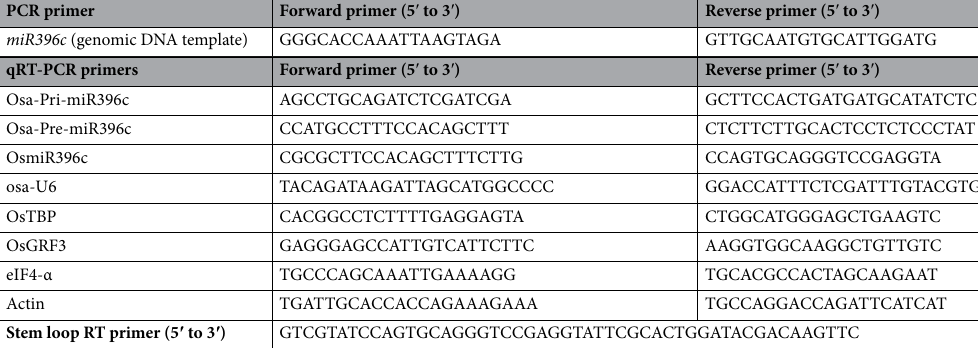
PCR primer Forward primer (5 ′ to 3 ′ ) Reverse primer (5 ′ to 3 ′